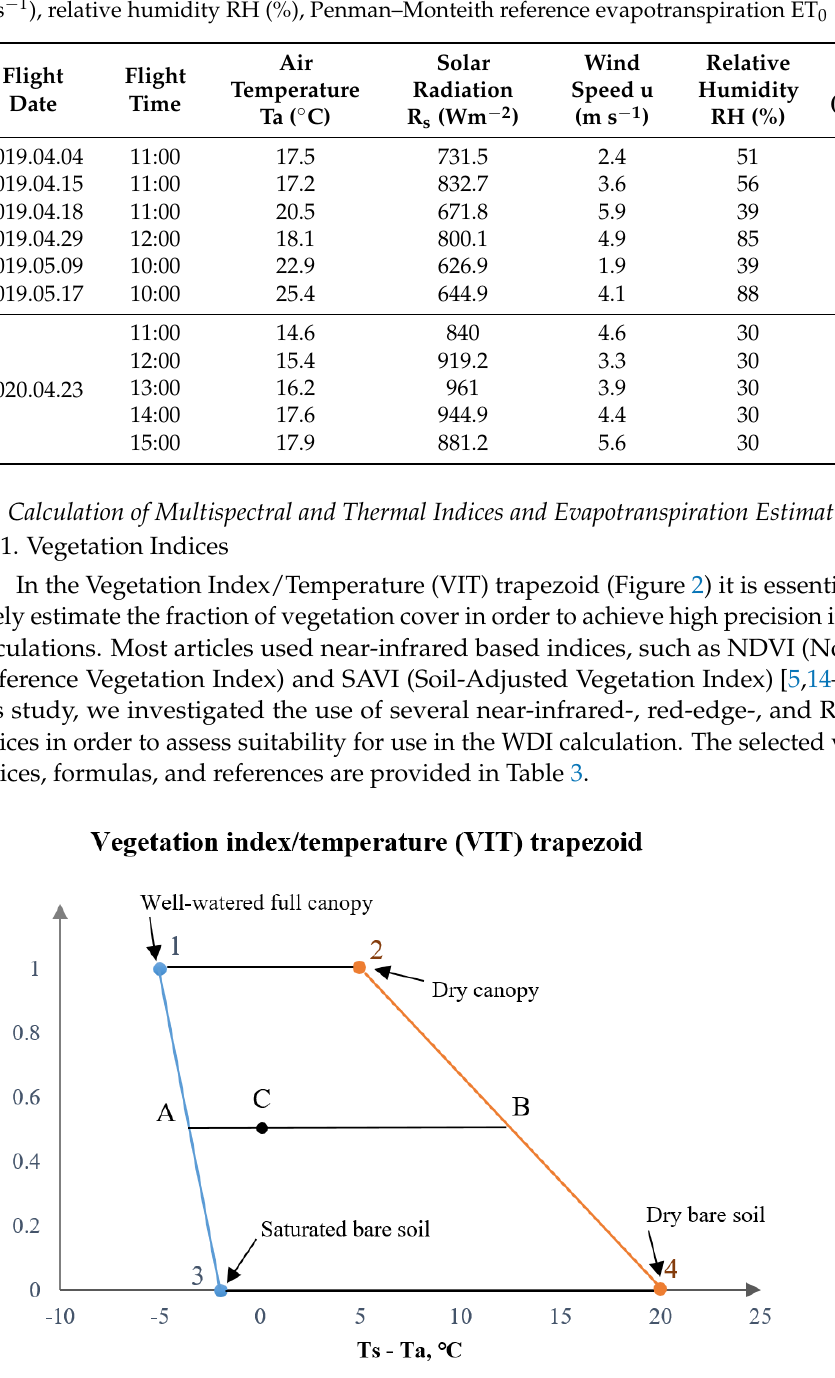
Table 2. Flight dates, time, and main environmental parameters at the time of the flight that were